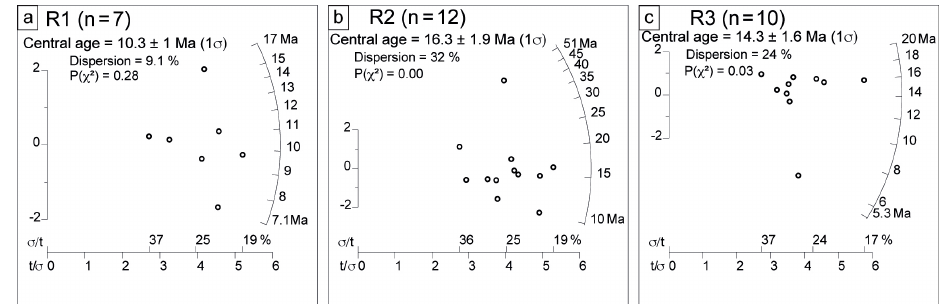
Figure 7. Radial plots of zircon ages in the granite host rock. (a) R1 sample (cleft hanging wall); (b) R2 sample ( ∼ 30m from the cleft); (c) R3 sample ( ∼ 100m from the cleft).